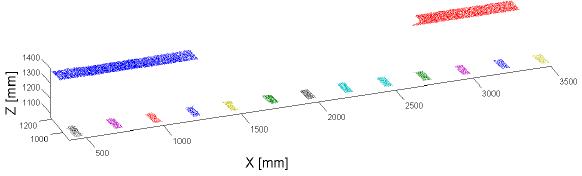
Figure 9. Example of a segmented 3D point cloud (Note: each segmented plane has a random colour assigned to